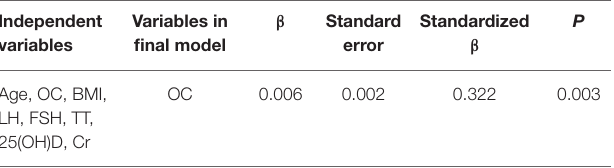
TABLE 3 | Factors determining the variations in body fat% and 2hPG in multivariate stepwise regression